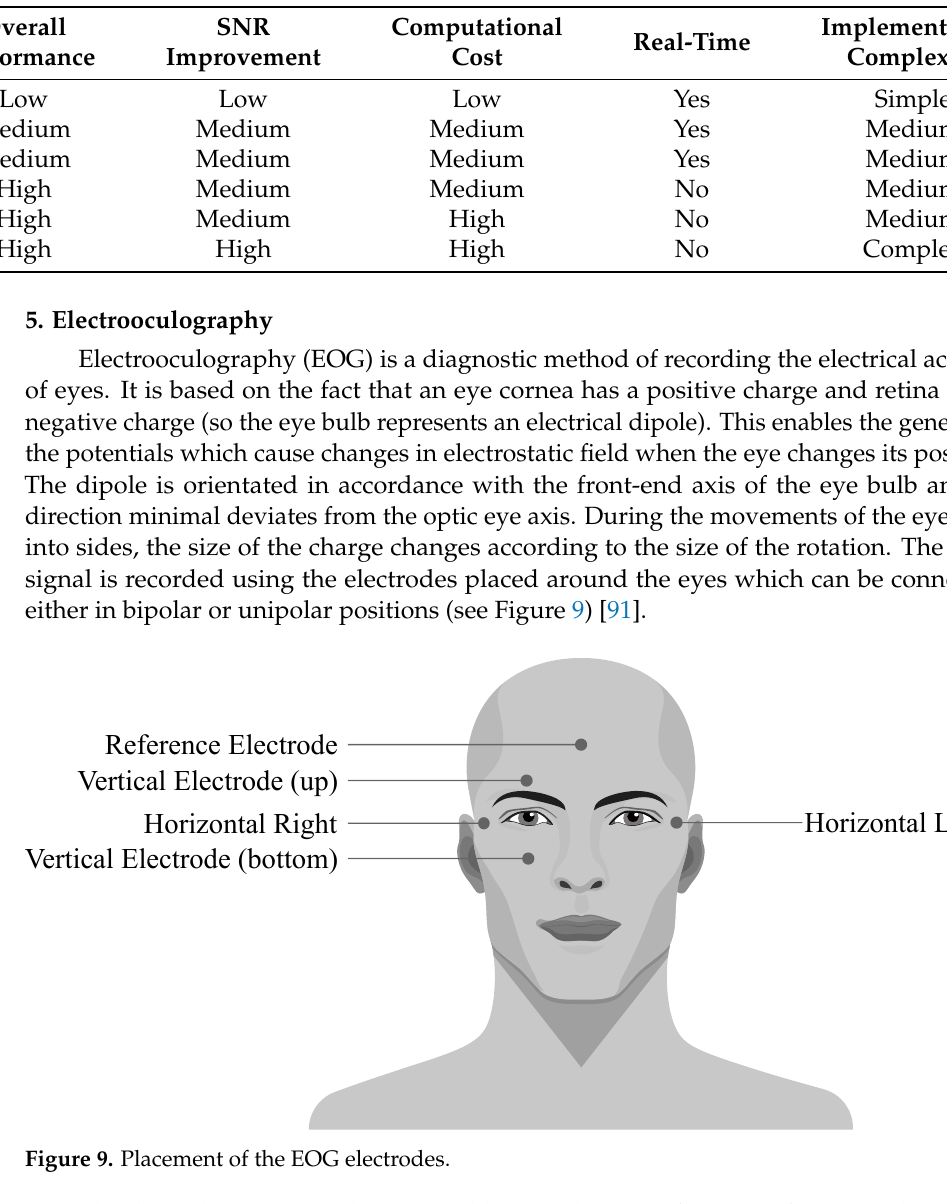
Table 3. Summary of the EGG signal processing methods.